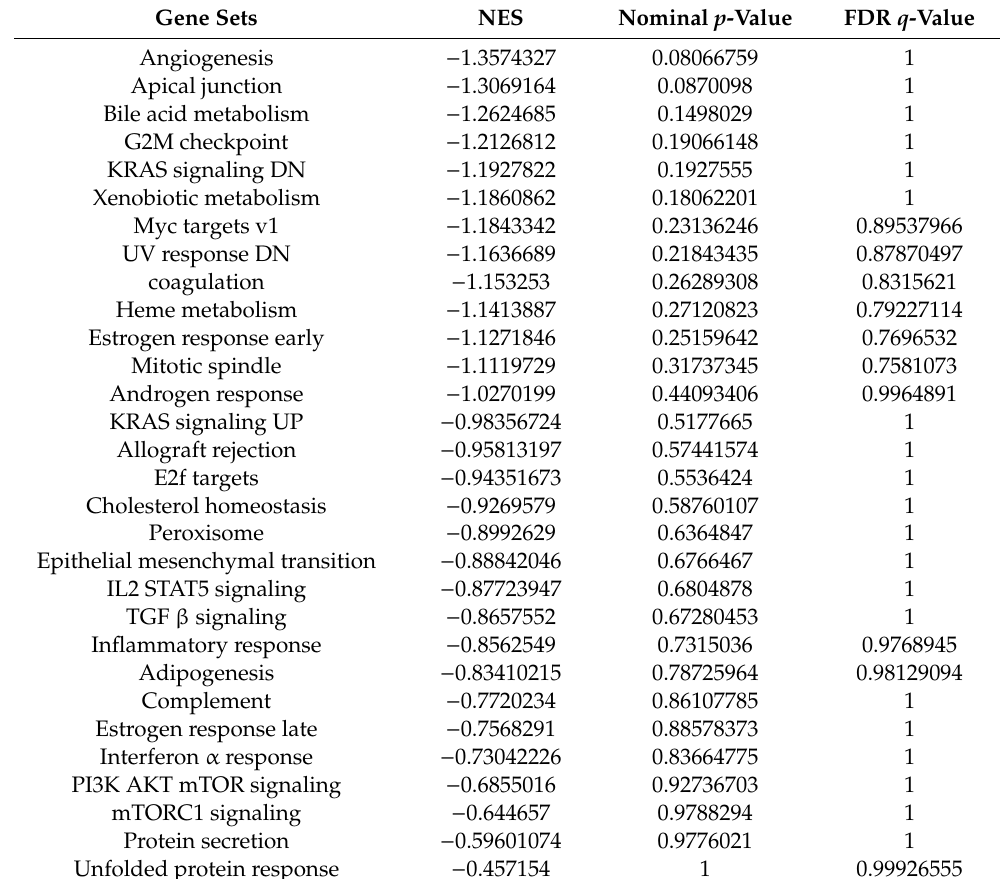
Table 2. Downregulated gene sets of the contralesional cerebellar